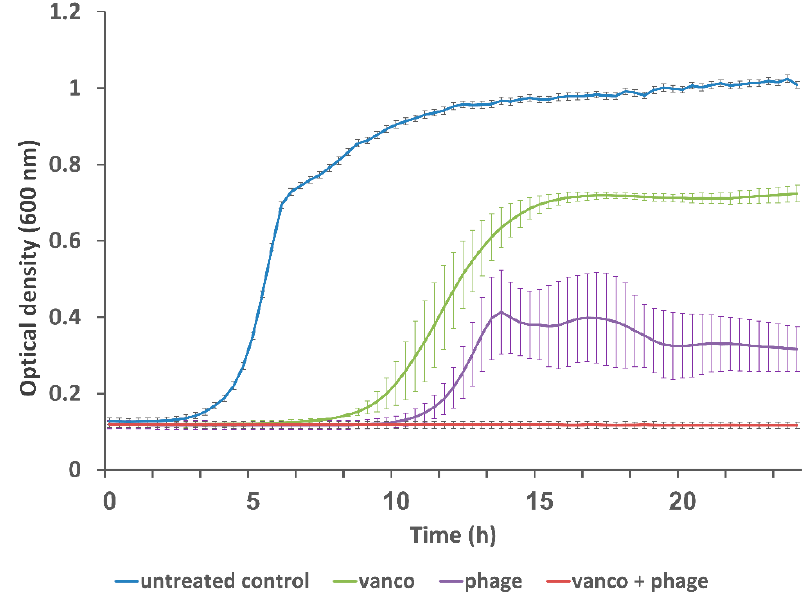
Figure 2. Treatment of planktonic bacteria with 1.2 × 10 8 plaque forming units (PFU) / well phage EFLK1 (anti- E. faecalis phage) combined with 0.015 mg / mL vancomycin reduced VRE growth. Total growth was inhibited in the combination of 0.015 mg vancomycin / mL and 1.2 × 10 8 PFU / well phage EFLK1 (red). VRE control depicts untreated bacteria showing maximal growth (blue). A longer lag phase was observed after treatment with 0.015 mg / mL vancomycin (green) or phage EFLK1 (1.2 × 10 8 PFU / well) alone (purple). The combined treatment reduced the bacterial maximum optical density (OD) with better e ff ect than that of the phages or vancomycin alone. The results are mean ± SD based on 3 independent biological replicates.